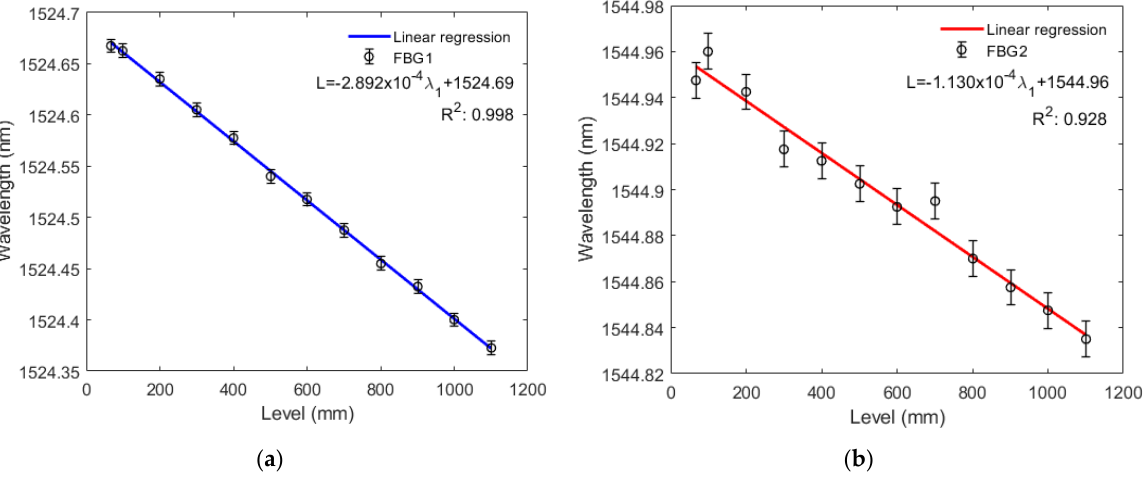
Figure 9. ( a ) Bragg wavelength shift as a function of the tank level reduction for FBG1; ( b ) Bragg wavelength shift as a function of the tank level reduction for FBG2.